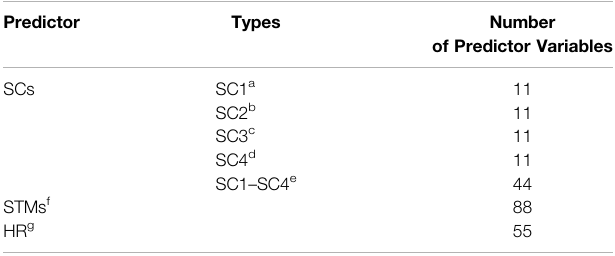
TABLE 3| Model-speci fi cpredictorvariables.Each predictor includes sixspectral bands (blue, green, red, NIR, SWIR1, and SWIR2) and fi ve vegetation